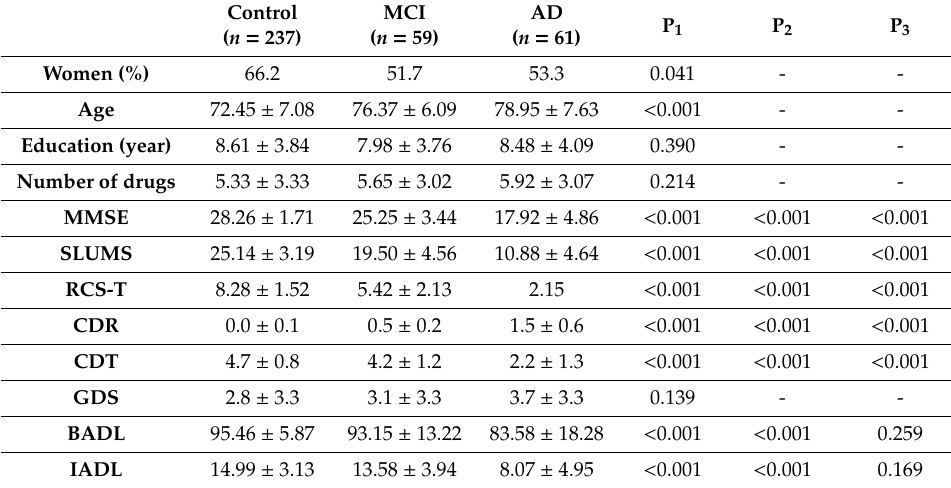
Table 1. Descriptive characteristics of participants ( n =